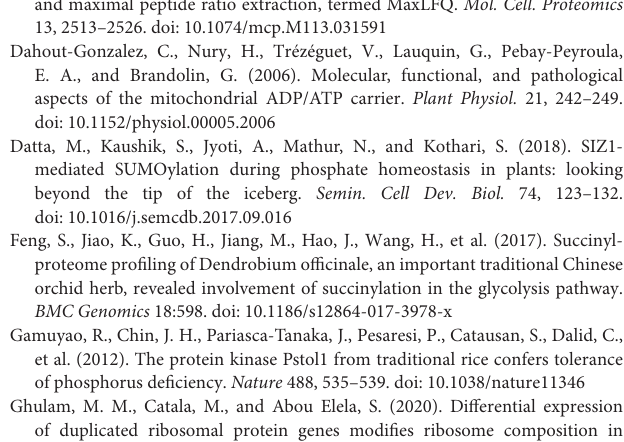
Supplementary Table 9 | Overlap of identified DAPs with DFASPs in roots in response to Pi stress. Supplementary Table 10 | Overview of the succinylated proteins used to construct the protein–protein interaction (PPI) network in response to Pi starvation and Pi recovery. Supplementary Table 11 | Lysine succinylation analysis in different plant species. Supplementary Table 12 | Statistics of DFASPs that were co-expressed differentially in roots during Pi starvation and recovery. Supplementary Table 13 | KEGG pathway enrichment analysis of DFASPs in roots under Pi starvation and recovery. Supplementary Table 14 | List of major succinylation-mediated proteins involved in short-term Pi starvation and recovery. Supplementary Figure 1 | Biological process enrichment analysis of DFASPs in roots under Pi starvation (6, 48h) and Pi recovery (6, 48h). Supplementary Figure 2 | Subcellular localization of DFASPs in roots under Pi starvation (6, 48h) and Pi recovery (6 and 48h). Supplementary Figure 3 | InterPro domain enrichment of DFASPs in roots under Pi starvation (6, 48h) and Pi recovery (6, 48h) ( P < 0.05). Circle size represents the number of succinylated proteins within the domain family. Colors represent the significance of enrichment. Supplementary Figure 4 | Summary of DAPs in response to Pi starvation and recovery. (A) Summary of the proteins identified and quantified; (B) overview of DAPs (fold change > 1.5, P < 0.05); (C) KEGG pathway enrichment analysis of DAPs in roots during Pi starvation (6, 48h); (D) KEGG pathway enrichment analysis of DAPs in roots during Pi recovery (6, 48h). Supplementary Figure 5 | Venn diagram showing the number of proteins overlapping between DFASPs and DAPs in roots in response to Pi